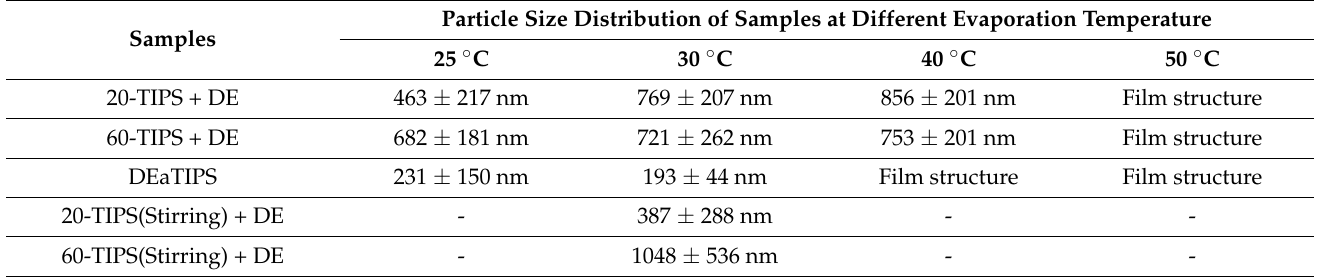
Table 2. Average particle size of samples obtained by different methods.